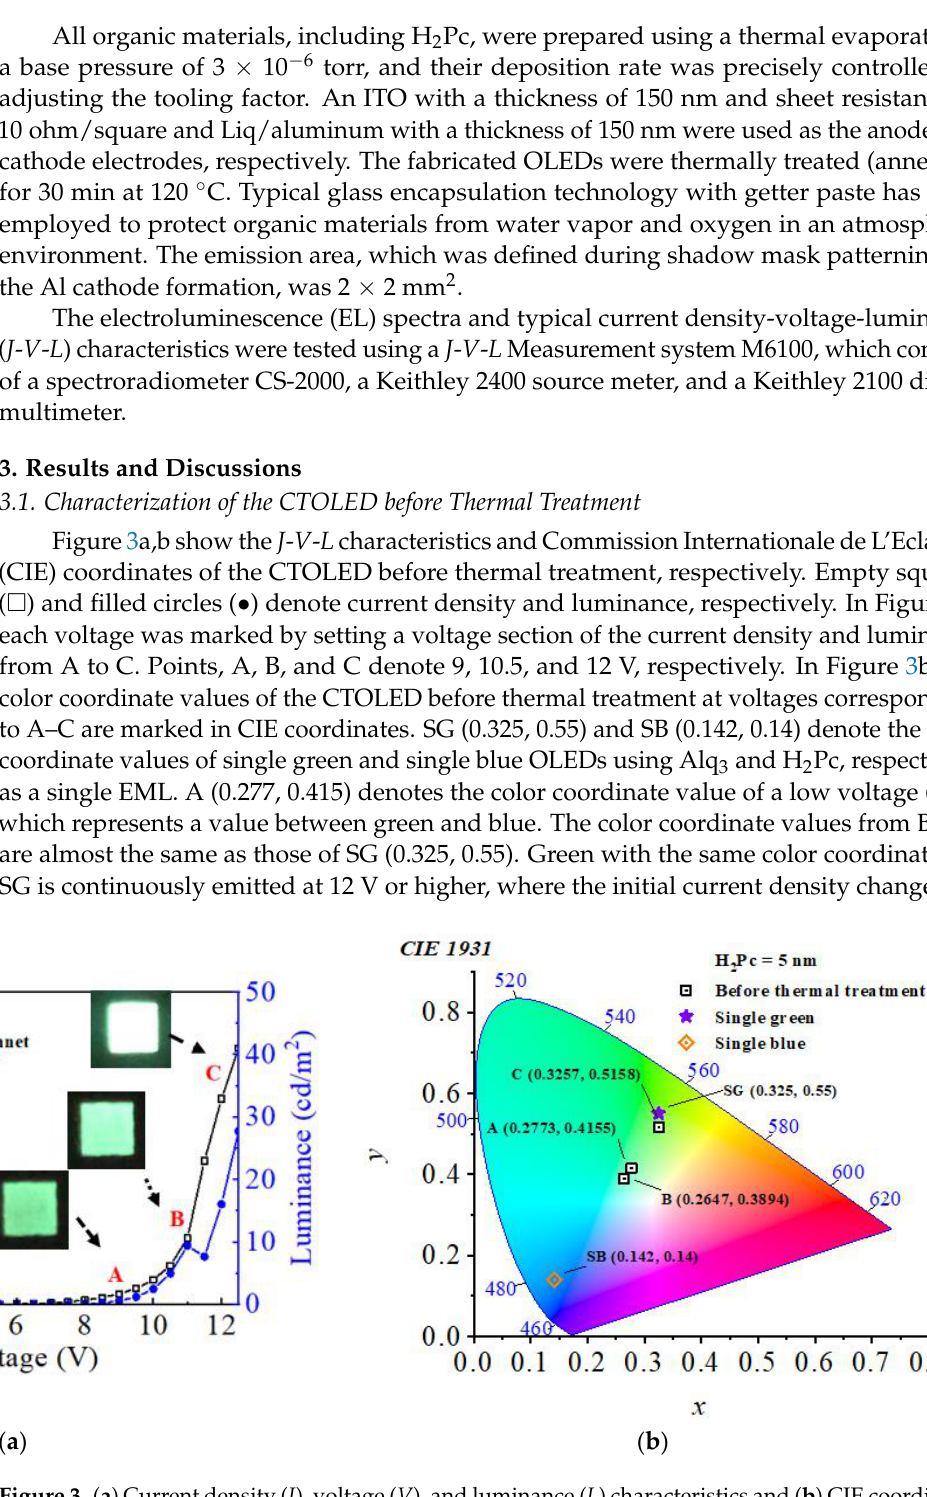
Figure 2. Energy band diagram of the CTOLED. ( a ) An OLED with only Alq 3 as the EML and ( b ) a CTOLED with H 2 Pc and Alq 3 as EMLs.